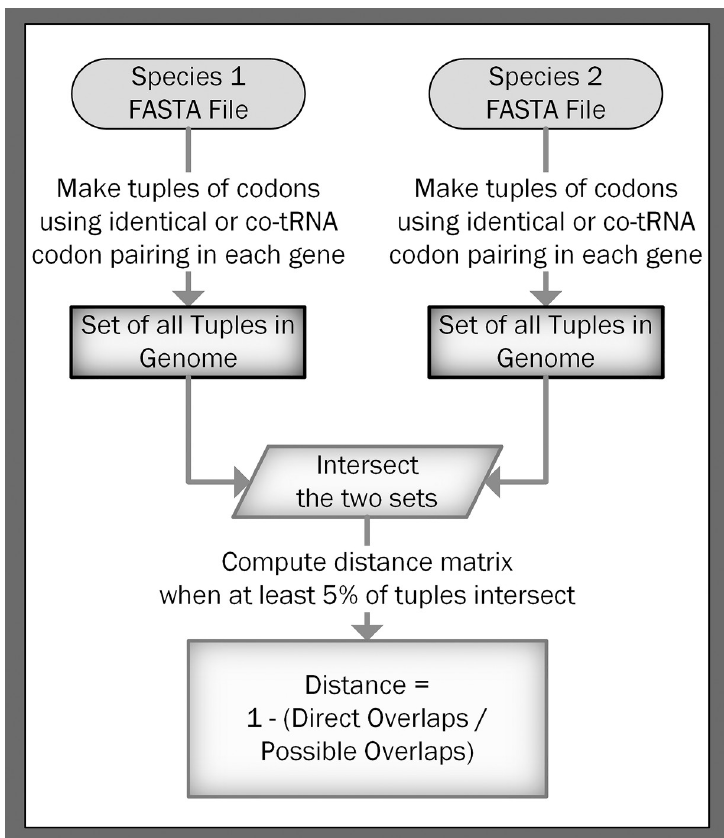
Fig 3. Process to calculate the distance matrix. Starting with the coding sequences of each gene in a species (FASTA file), codons that use codon pairing within the ribosomal footprint are included in a tuple that is then added to a set for that species. Sets of tuples are intersected to calculate the distance between species. These distances are then added to a distance matrix that can be used to recover phylogenies.